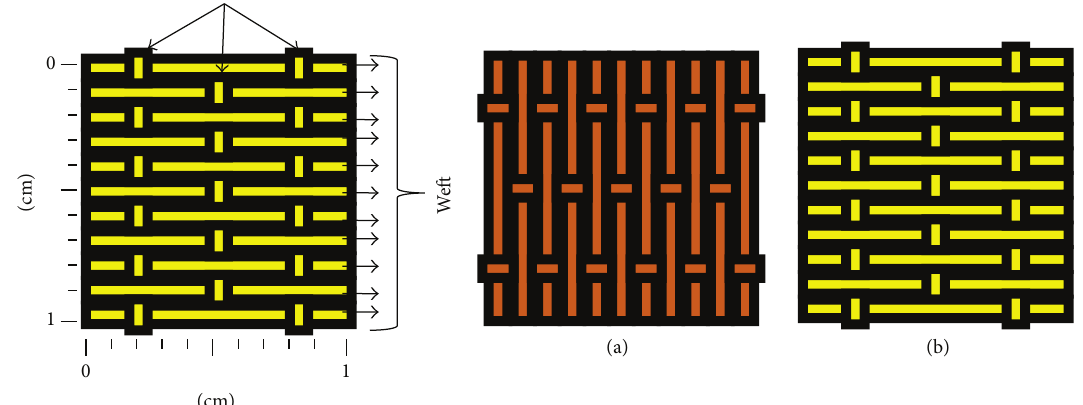
Figure 3: Schematic of kenaf woven orientation. (a) Orientation A, (b) orientation B.